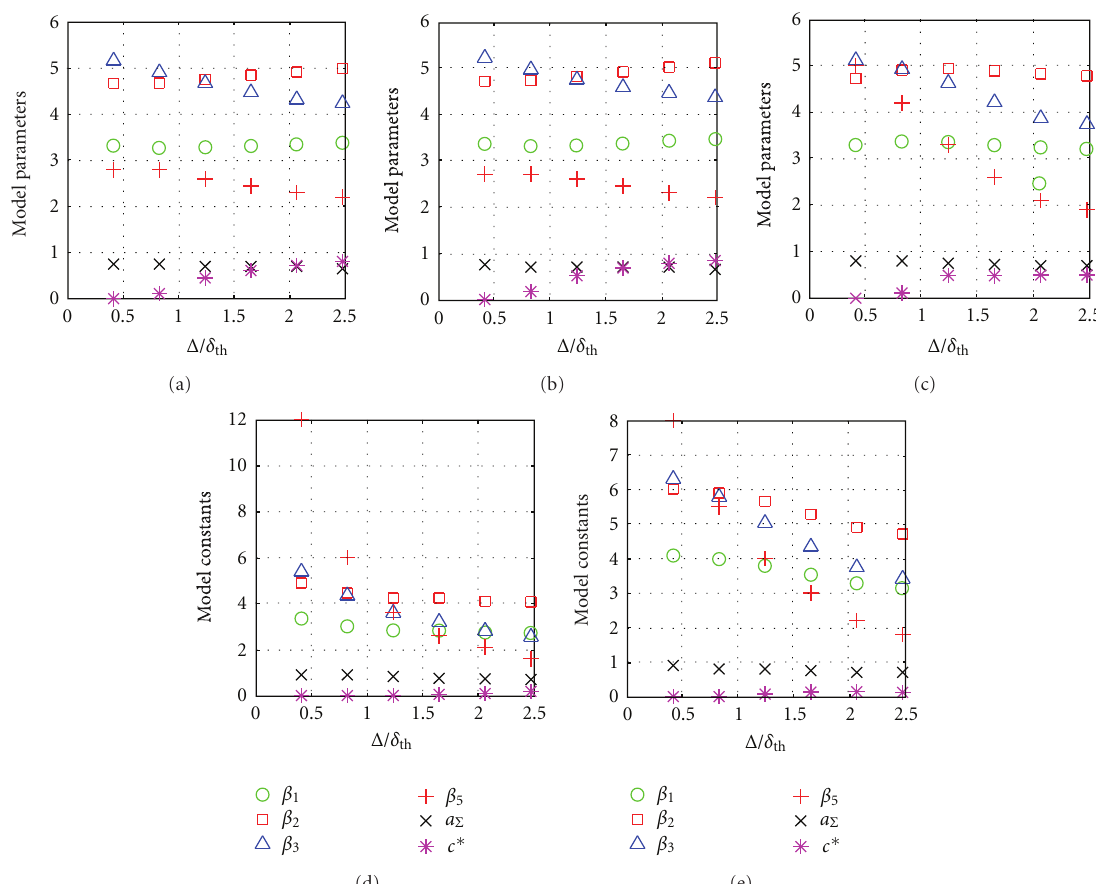
Figure 6: Variations of the model parameters β 1 , β 2 , β 3 , β 5 , a Σ and c ∗ with Δ /δ th for cases: (a–e)